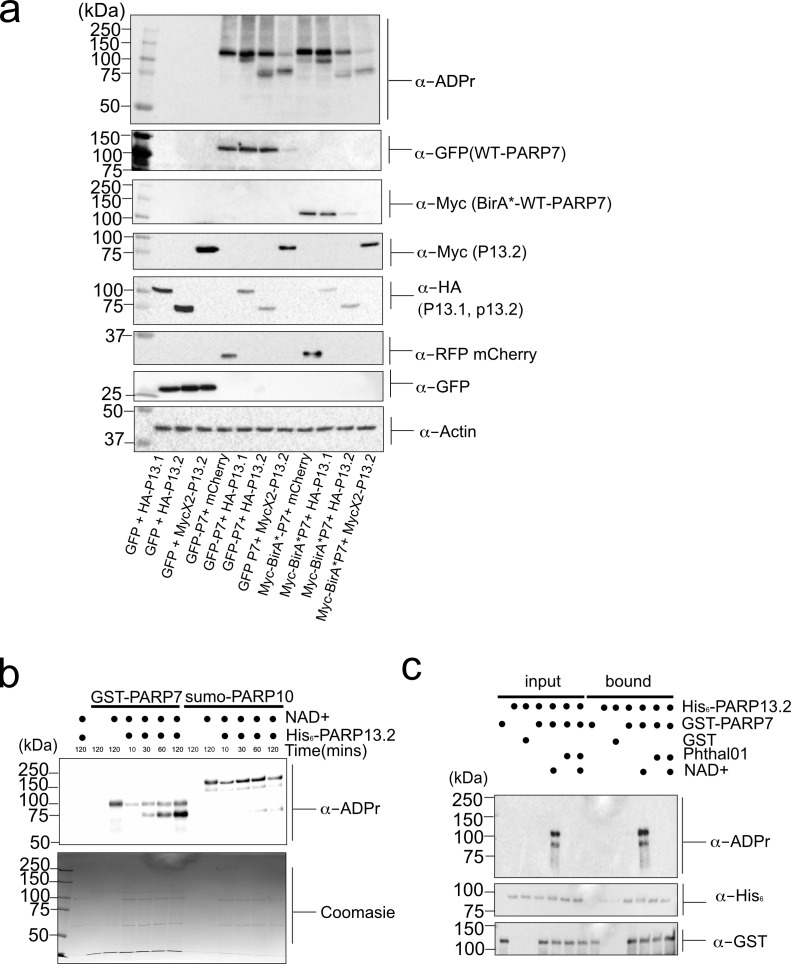
PARP-13 is a MARylation target of PARP-7.(a) PARP-7 MARylates PARP-13.1 and PARP-13.2 in cells. MARylation of PARP-13.1 and 13.2 by PARP-7. GFP-PARP-7 and PARP-13.1 and PARP-13.2 tagged variants were transfected in HEK 293 T cells. Proteins were resolved by SDS-PAGE and were detected by Western blot using antibodies against ADPr, GFP, HA, Myc, RFP (mCherry), and actin. Representative figure of data collected over three biological replicates. (b) PARP-7 MARylates PARP-13.2 in vitro. GST-PARP-7 (or His6-SUMO-PARP-10) was incubated with His6-SUMO-PARP-13.2 in the presence of NAD+ (100 μM). MARylation reactions were stopped at indicted time points and proteins were resolved by SDS-PAGE and were detected by Coomassie stain and Western blot using the antibody against ADPr. (c) The interaction between PARP-7 and PARP-13.2 is independent of PARP-7 catalytic activity. Recombinant GST-PARP-7 and His6-SUMO-PARP-13.2 were incubated for 1 hr and then subjected to GST pulldown following conditions described in the figure. Proteins were resolved by SDS-PAGE and were detected by Western blot using antibodies against ADPr, His6, and GST.